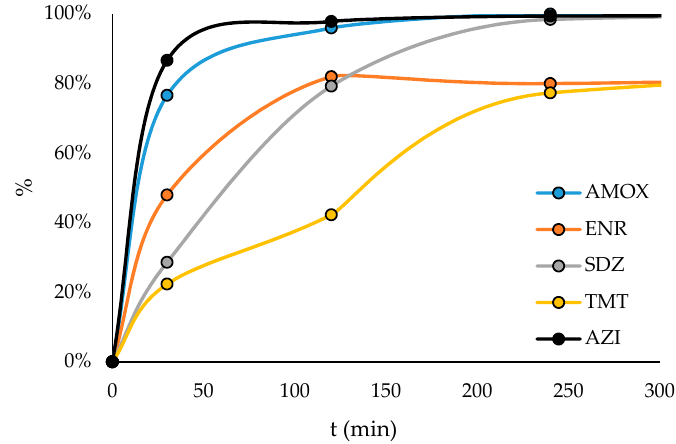
Figure 5. TiO 2 photocatalysis degradation yields of each antibiotic in WWTPE during 240 min of treatment (individual antibiotic initial concentration = 1 mg / L, TiO 2 initial concentration = 1 g / L, radiation per unity of volume = 0.3 W / L). AMX = amoxicillin, AZI = azithromycin, ENR = enrofloxacin, SDZ = sulfadiazine, TMT = trimethoprim.